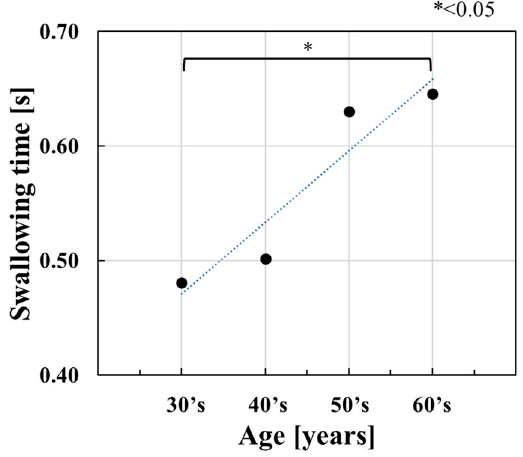
Figure 11. Change in swallowing times versus age in male subjects.